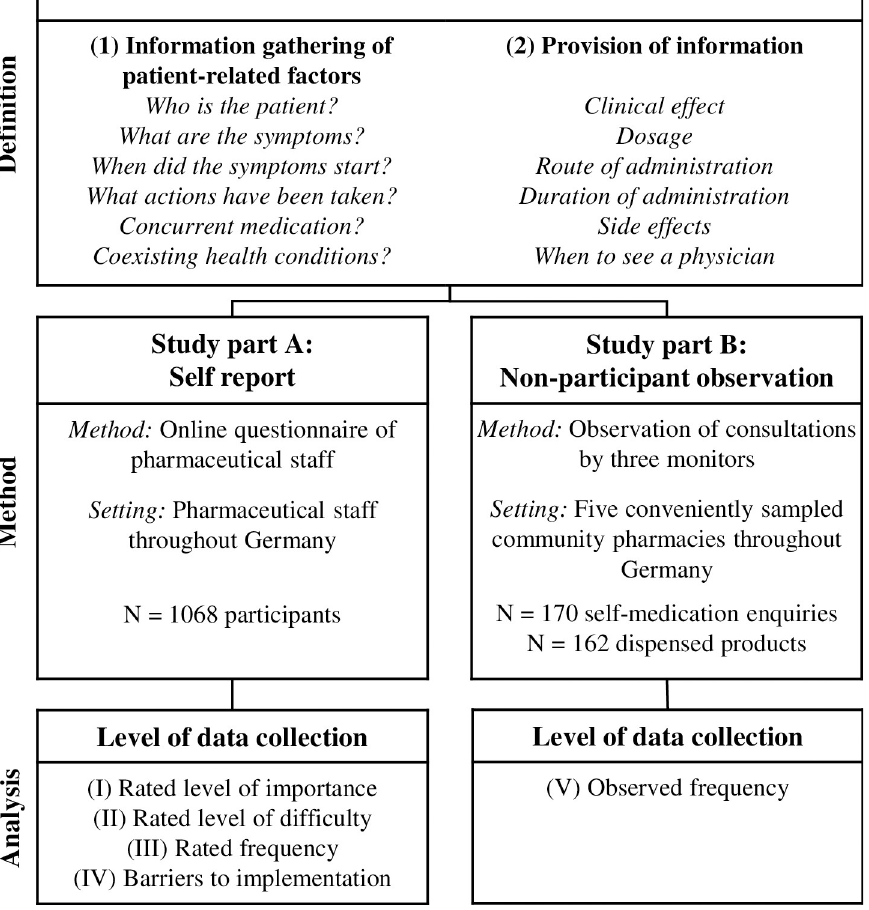
Fig 1. Overview of the two study parts with different levels of data collection and